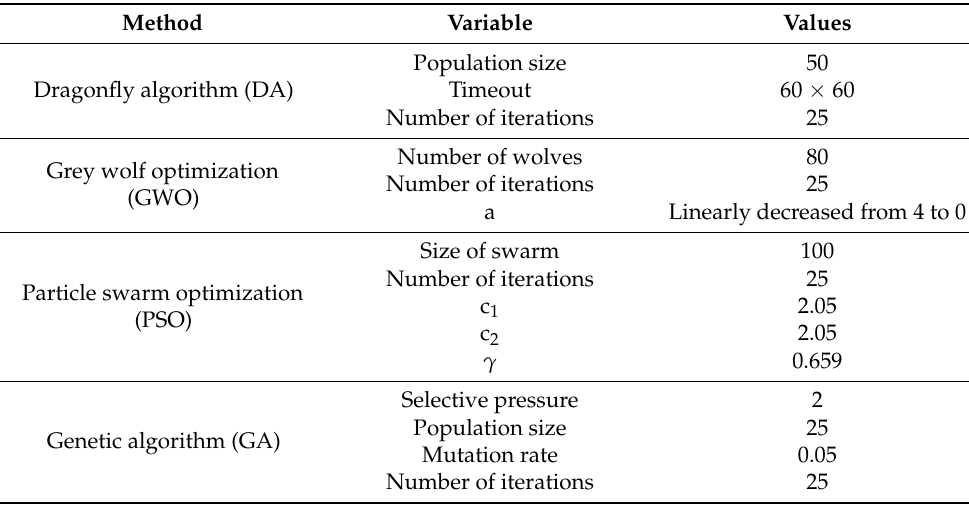
Table 4. The parameter setting is considered for each optimization